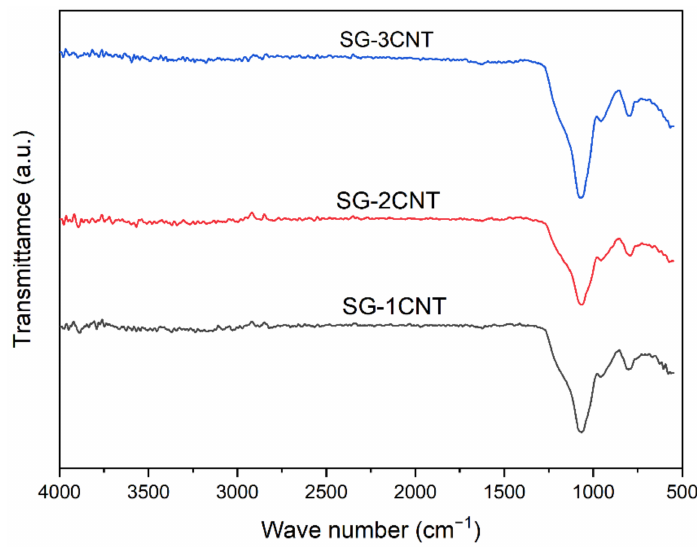
Figure 8. FTIR spectra of SG/MWCNT composites at various concentrations after